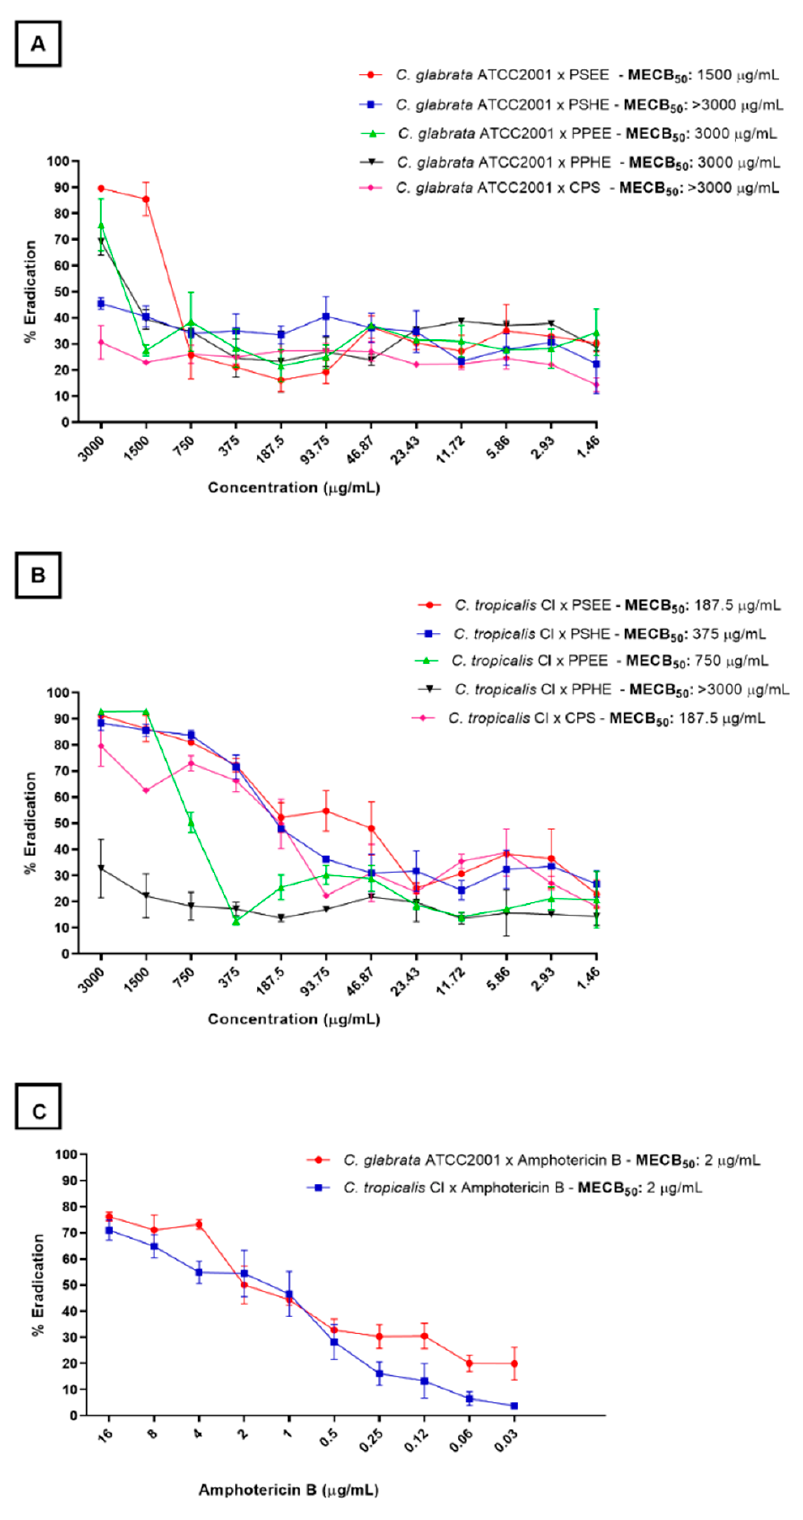
Figure 3. Percentage of viable cell eradication from the preformed C. glabrata (ATCC2001) ( A ) and C. tropicalis (CI) ( B ) biofilms at different concentrations of the hexane and ethanolic extracts